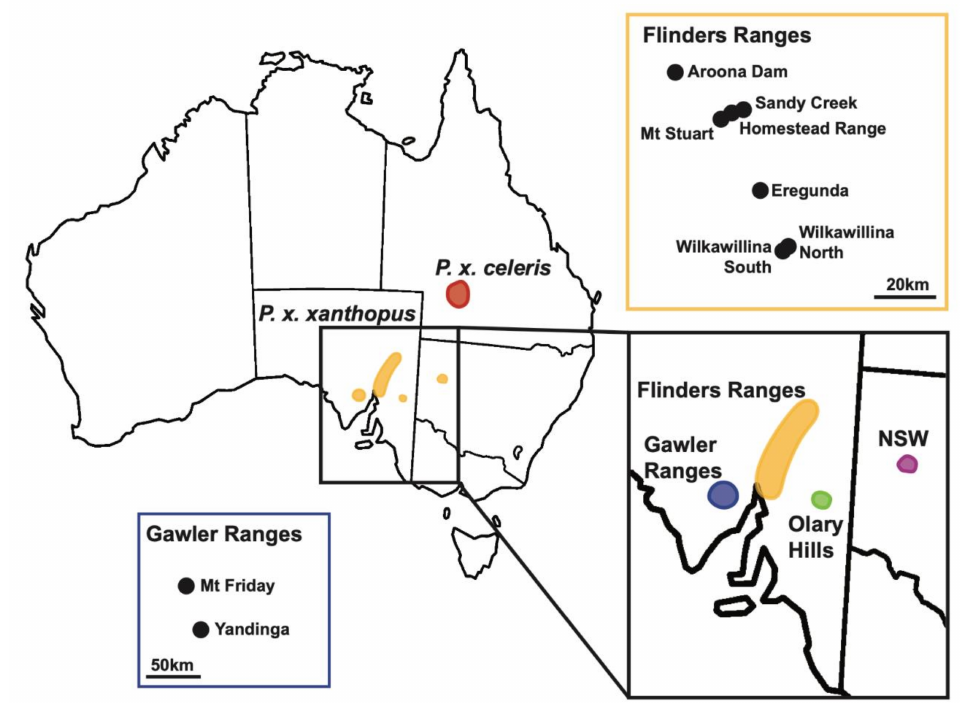
Figure 1. Map of the distribution of the yellow-footed rock-wallaby ( Petrogale xanthopus ) in Australia. The yellow populations outline the distribution of the subspecies P. xanthopus xanthopus in South Australia and New South Wales, and the red population highlights the distribution of P. x. celeris in Queensland. Inset, the populations and distributions of P. x. xanthopus from South Australia outline the distribution and populations across the Flinders Ranges (yellow), Gawler Ranges (blue), and Olary Hills (green) in South Australia, and the New South Wales (purple)